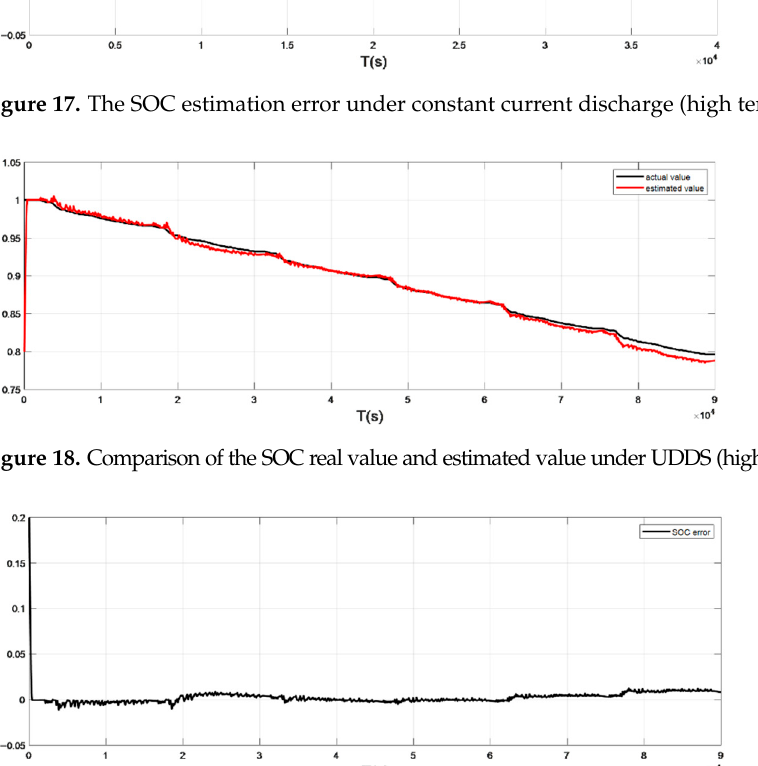
Figure 19. The SOC estimation error under UDDS (high temperature: 50 °C).